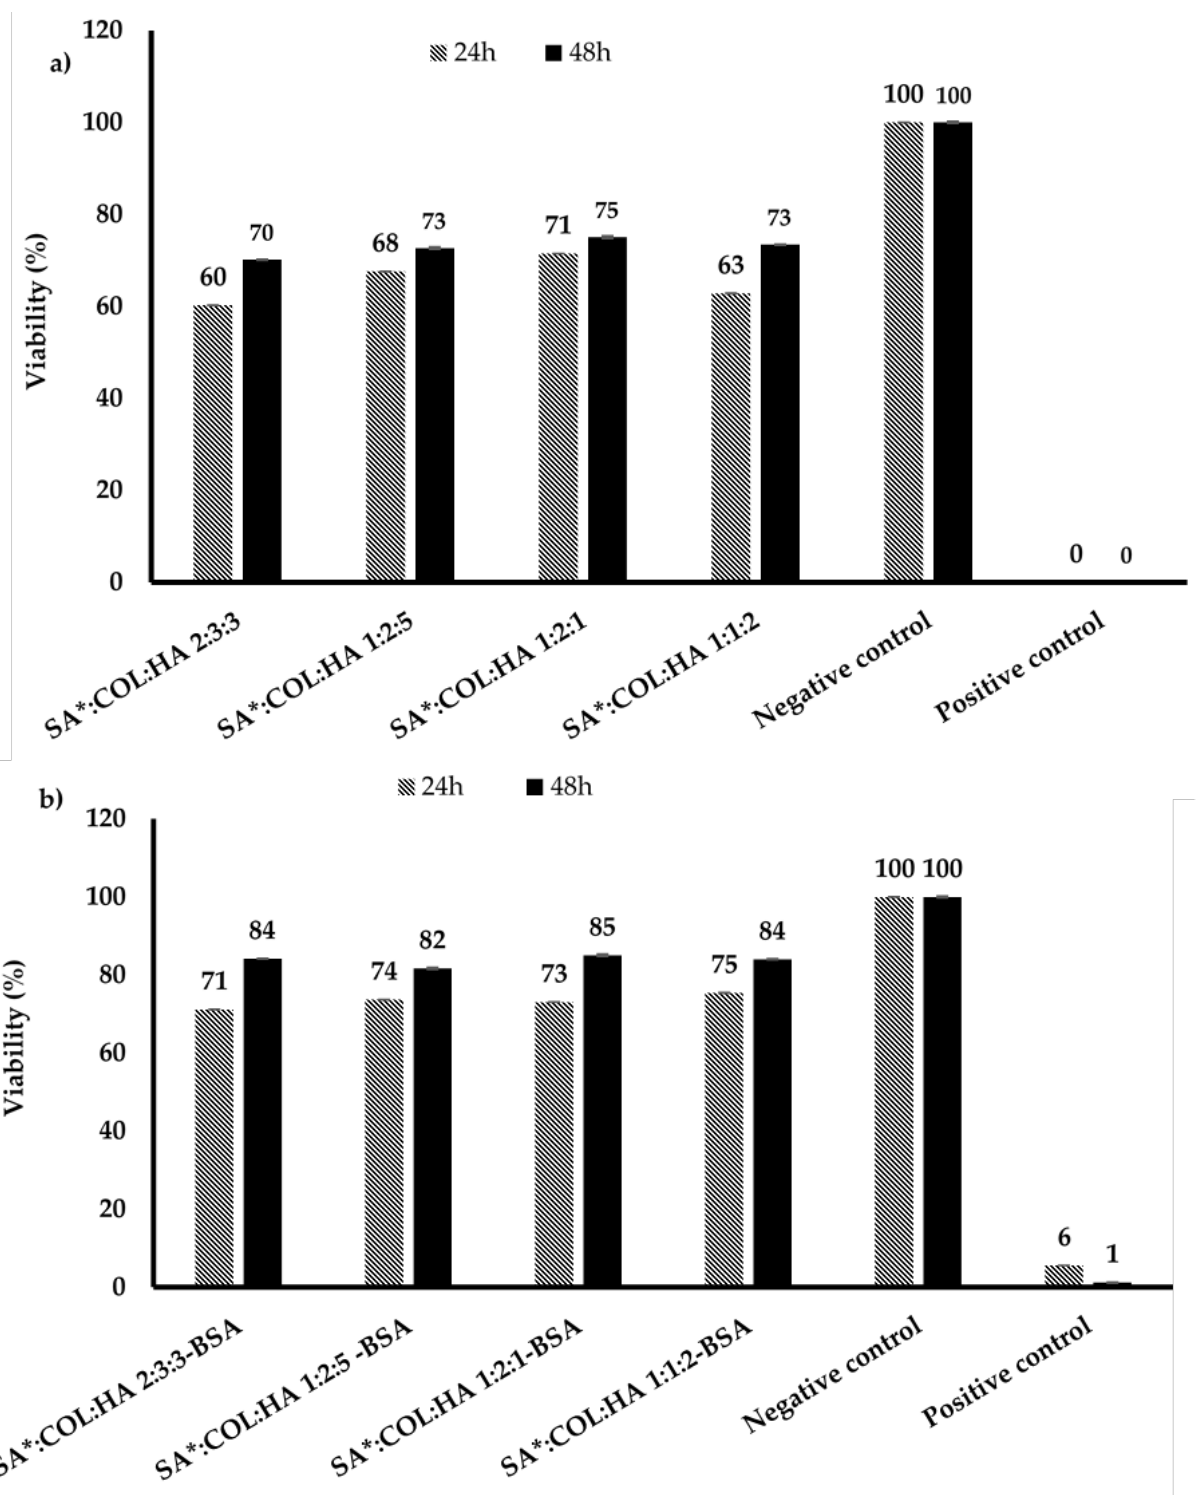
Figure 11. Cell viability of ( a ) primary HDFs after exposure to the SA*COL:HA blank scaffolds for 24 and 48 h (mean ± SD, n = 9); ( b ) primary HDFs after exposure to the BSA SA*COL:HA loaded scaffolds for 24 and 48 h (mean ± SD, n = 9).